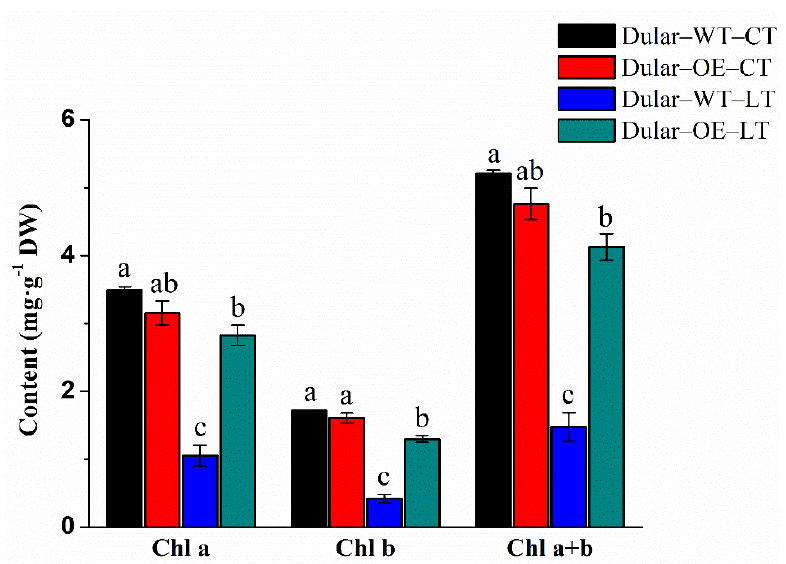
Figure 3. The chlorophyll content in rice leaves. Columns with different letters are significantly different (LSD test, p < 0.05). Error bars are the standard error (±SE) of three biological replications. DW: dry weight; CT: normal temperature; LT: low temperature.